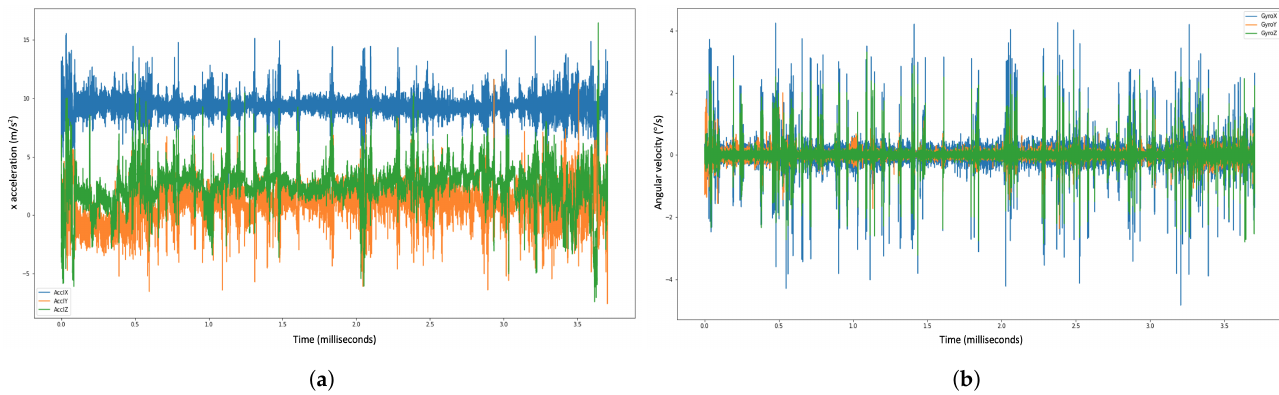
Figure 3. Example of the accelerometer and gyroscope data visualization for the validation dataset. AcclX , AcclY , and AcclZ denote the x − , y − , and z − axis of the 3D accelerometer, respectively. Correspondingly, GyroX , GyroY , and GyroZ denote the x − , y − , and z − axis of the 3D-gyroscope sensor, respectively. ( a ) Accelerometer dataset. ( b ) Gyroscope